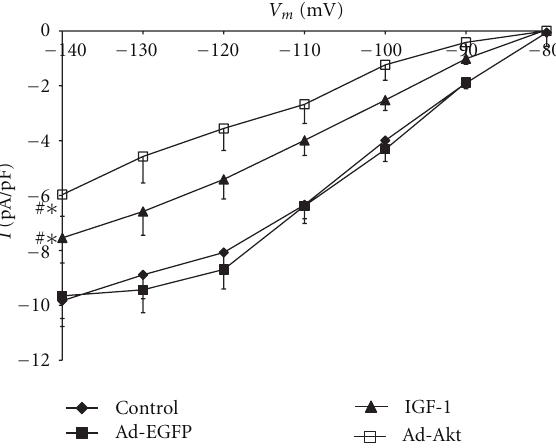
Figure 3: E ff ects of IGF-1, Ad.Akt, and Ad.BD110 in combination with LY294002 treatments on the I K -voltage relationship for normal neonatal rat cardiomyocytes. Data are presented as average current density (pA/pF) ± standard error.